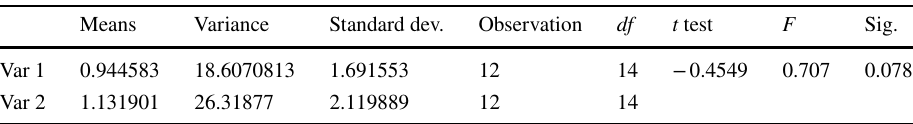
Means Variance Standard